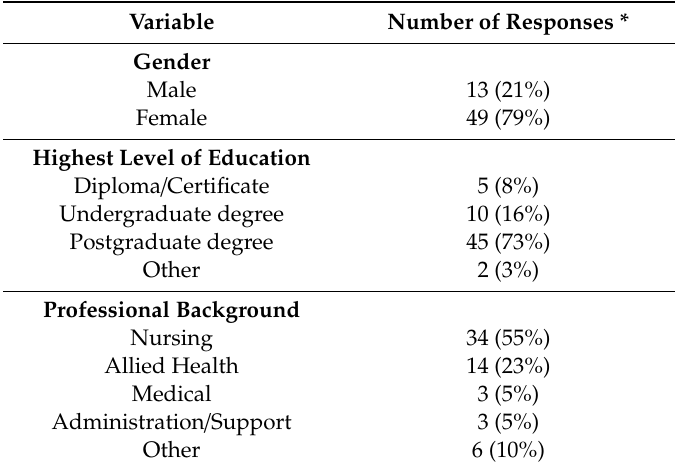
Table 2. Demographic data for survey